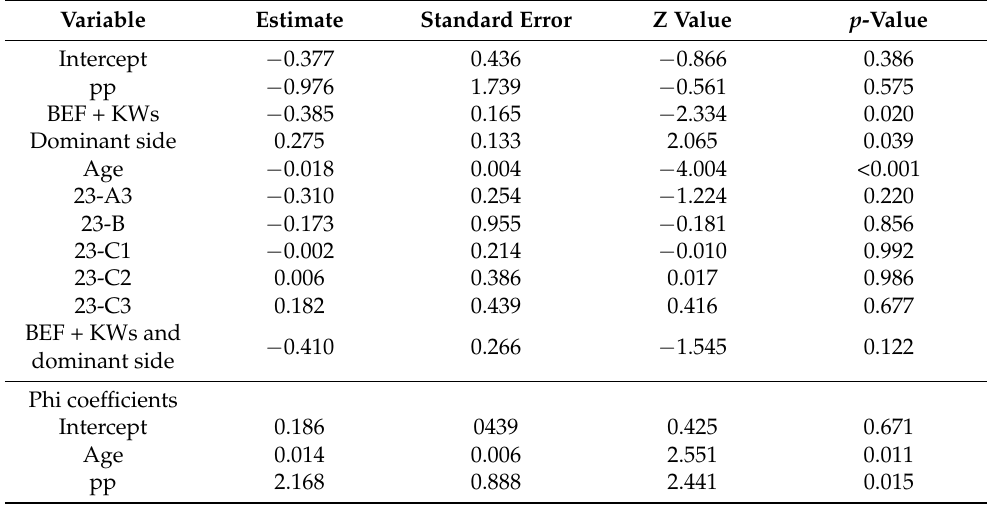
Table 3. Beta multivariate regression analysis of the impact of the different variables on PRWHE score.